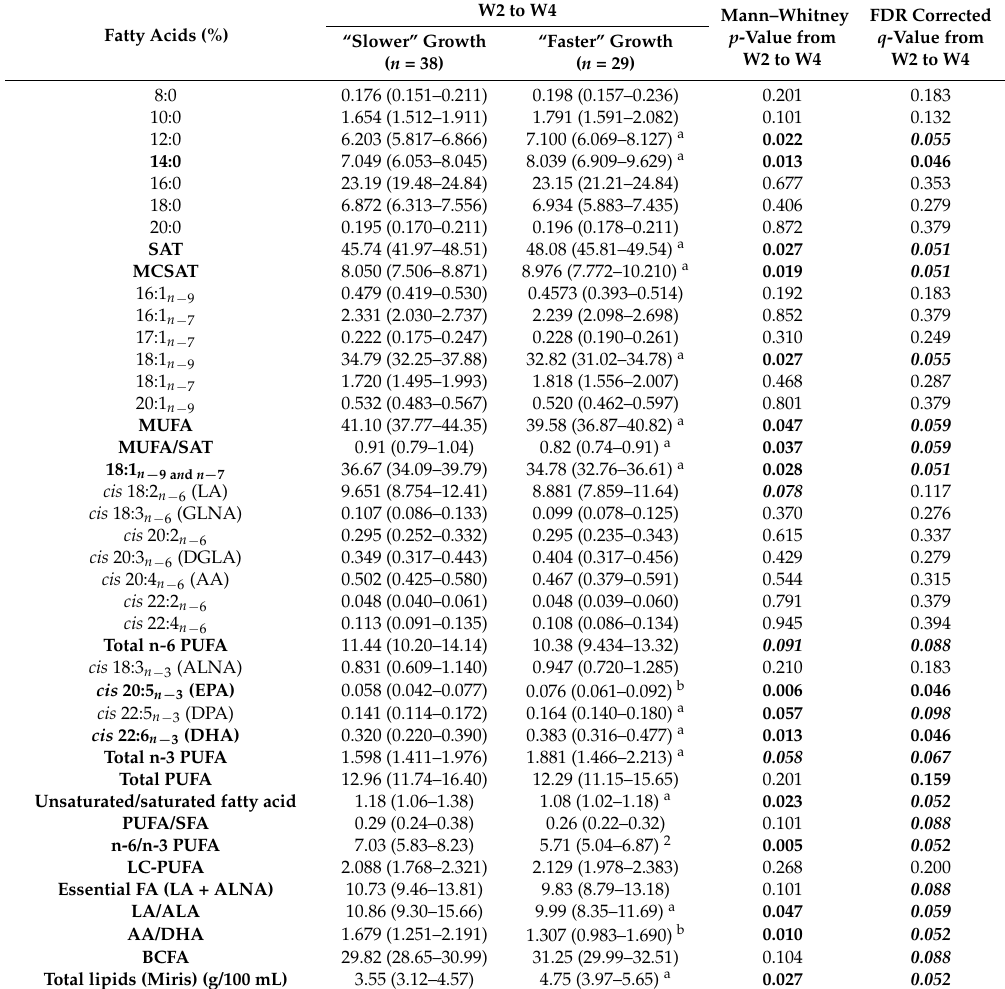
Table 2. Concentration levels of total fatty acids (free and triglycerides- and phospholipids-bound) in breast milk provided to preterm infants with “faster” or “slower” growth during the W2–W4 lactation